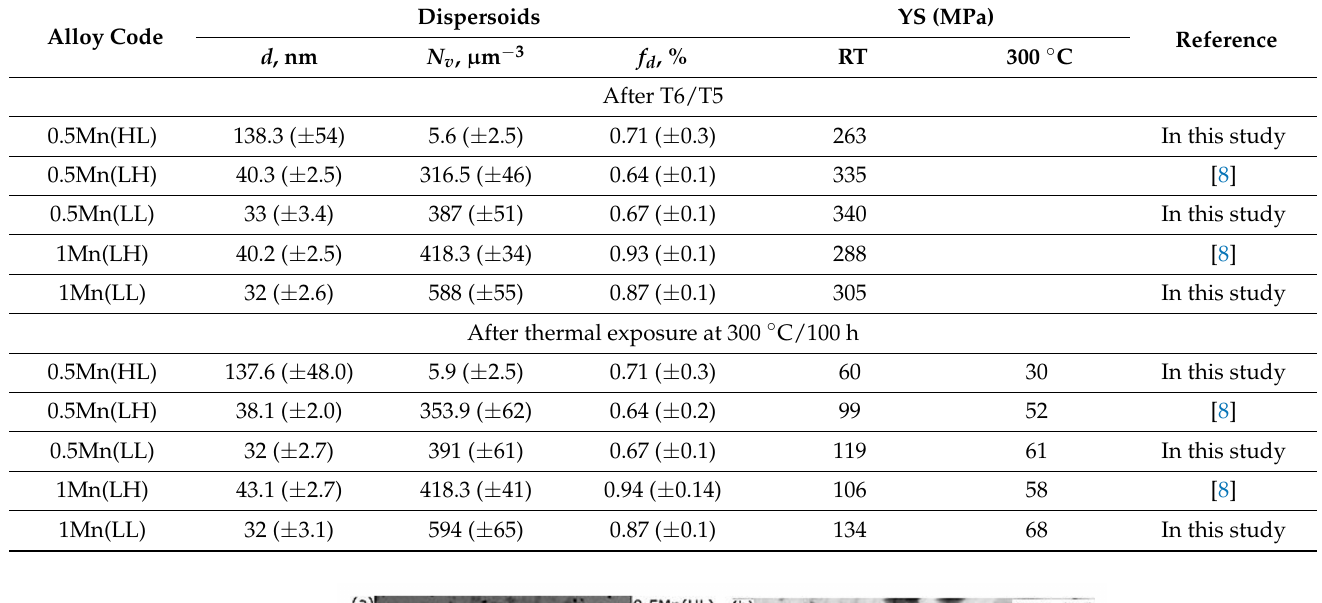
Table 3. Summary of quantitative TEM results of dispersoids and YS under various conditions.